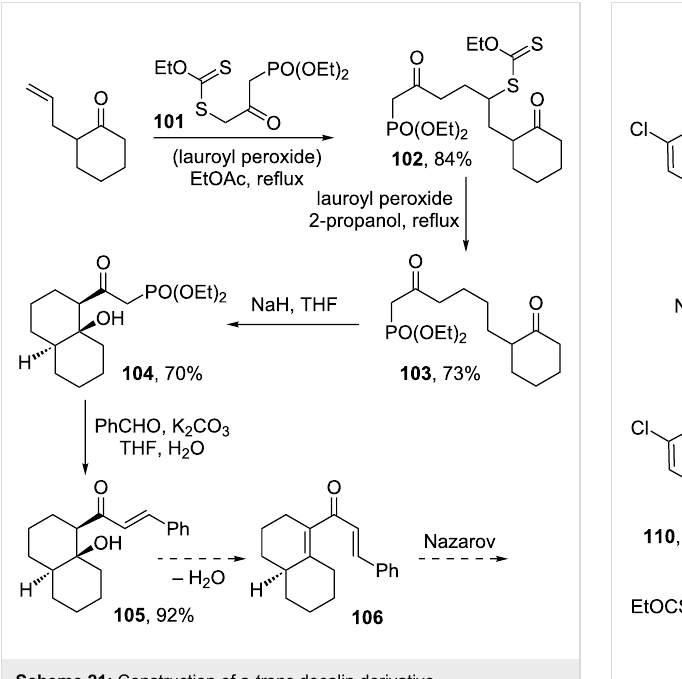
Scheme 21: Construction of a trans -decalin